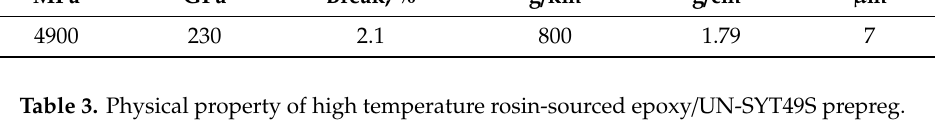
Table 2. Technical data of SYT49S, 12K, T700-grade carbon fiber.